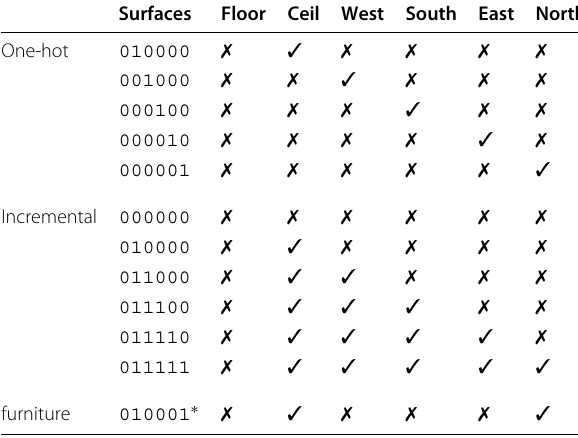
Table 2 Surface coding in the dataset: each binary digit